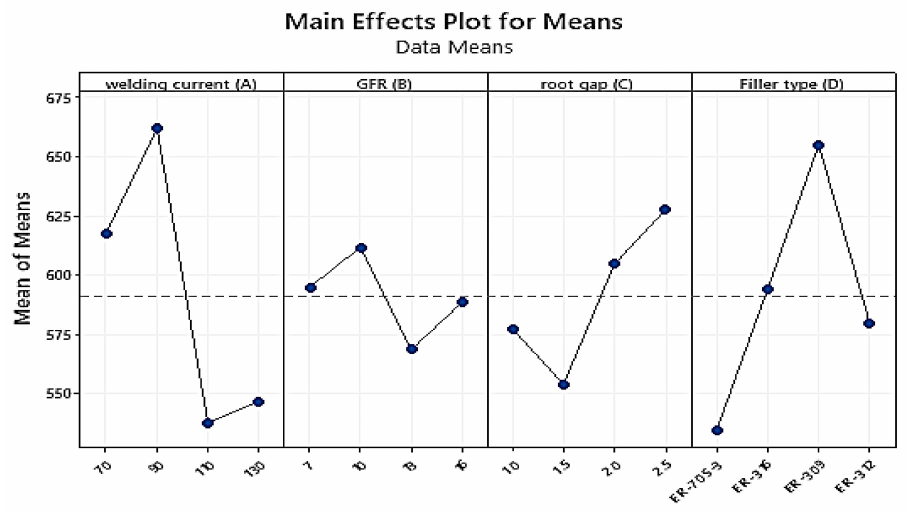
Figure 21. Main effect plot for the signal-to-noise ratios for Flexural Strengths.